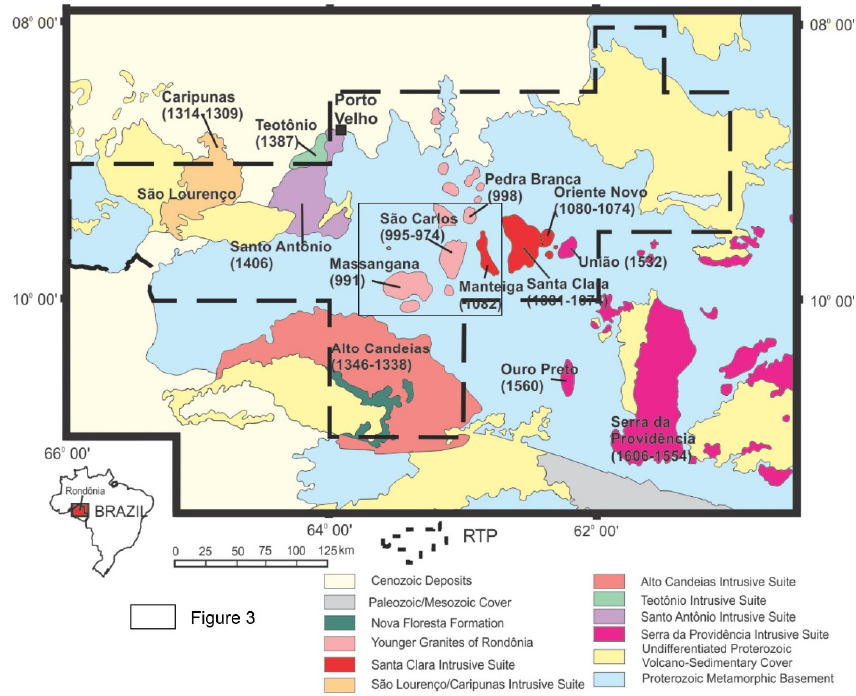
Figure 2. Limits of the Rondônia Tin Province were modified from [18,19]. The location of Figure 3 is presented as a black rectangle.